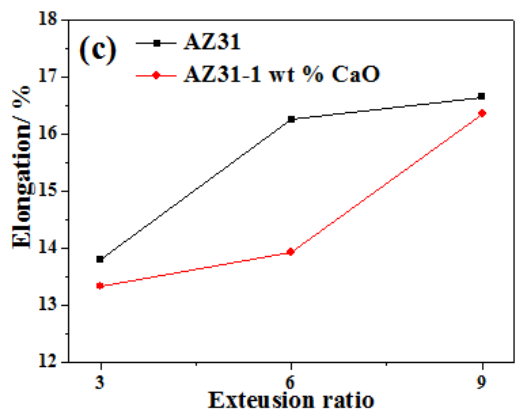
Figure 8. Tensile properties of AZ31 and AZ31-1%CaO alloys at different extrusion ratios. ( a ) Ultimate tensile strength; ( b ) yield strength; and, ( c ) elongation.